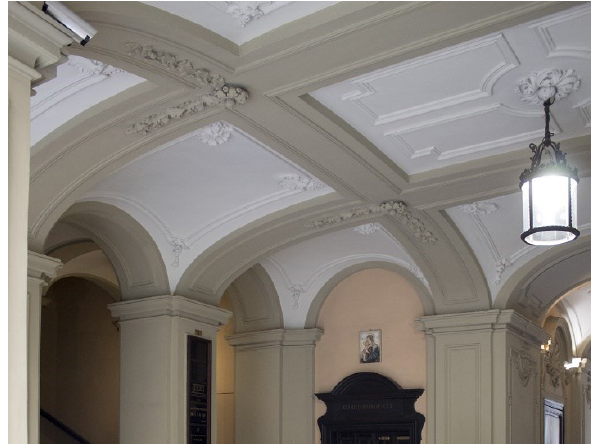
Figure 1. Banded vault in the atrium of the palace in Via dei Mercanti 2 in Turin. Photo: F.